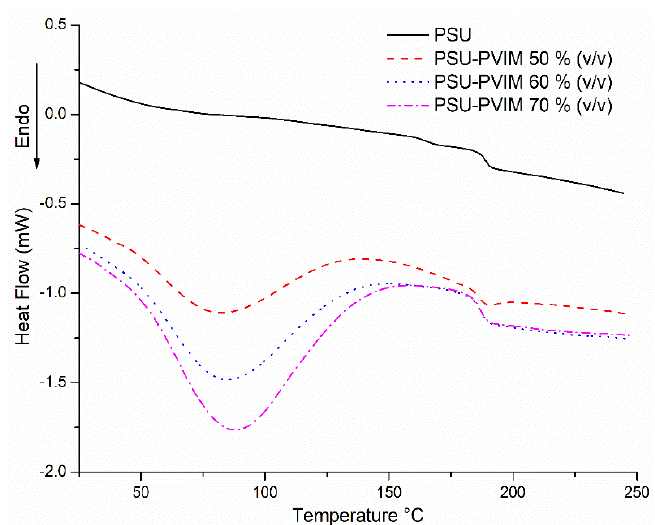
Figure 7. Thermal behavior obtained from DSC analysis, for the first heating scan of the grafted PSU membranes, with an irradiation dose of 300 kGy and VIM concentration between 50–70% (v/v).